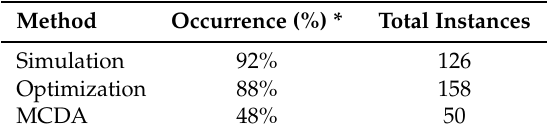
Table 6. Type of method in FMDSS.